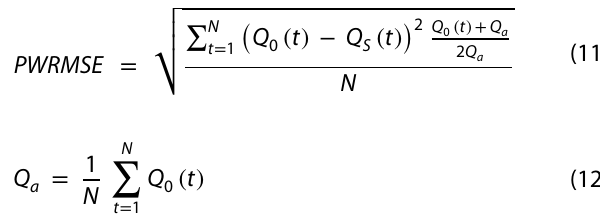
algorithm and the peak weighted root mean square error